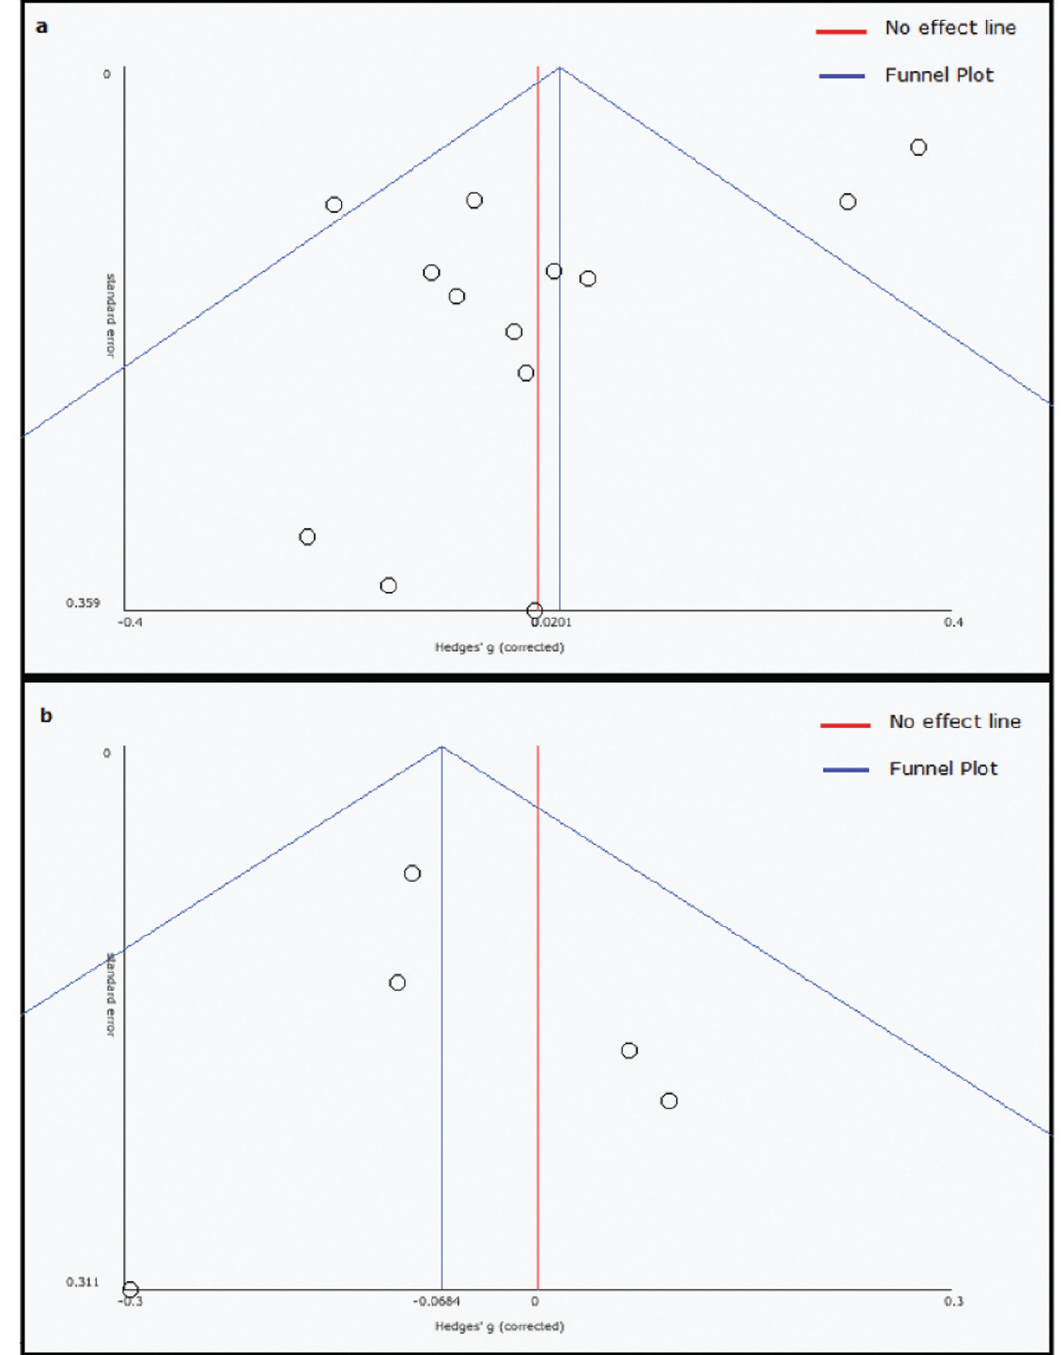
Figure 3 - Funnel plots of papers included in the body mass index synthesis (a) and body weight